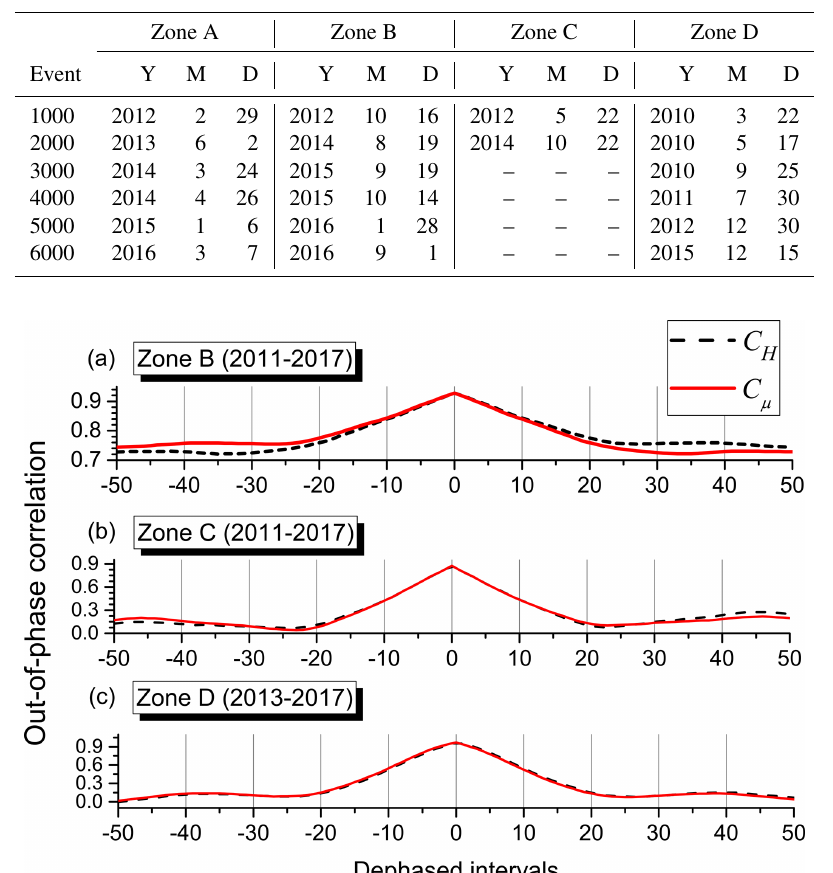
Figure 7. Out-of-phase correlations. (a) Zone B data including the aftershock regime (similar ones are obtained for zones A and D with aftershock regimes). (b) Zone C data that does not present an aftershock regime. (c) Truncated zone D data excluding the aftershock